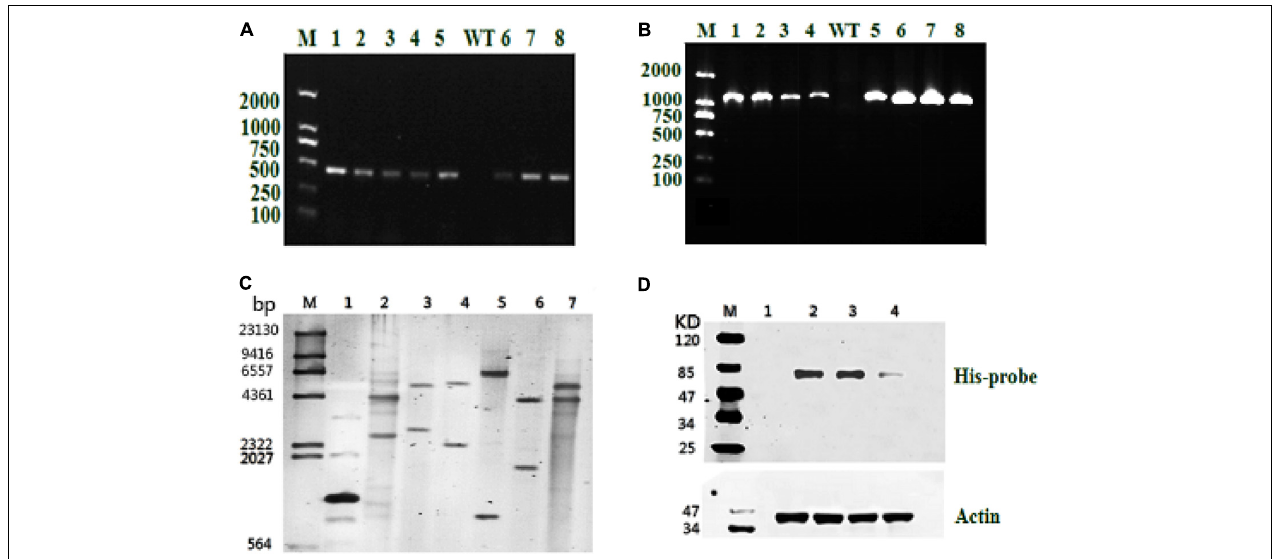
FIGURE 2 | Molecular analysis of resistant clones. (A) PCR of the resistant gene Sh-ble in selected clones and the WT strain. M: DNA-size marker. (B) PCR performed using primers designed from tandem ME1 and ble sequences in the recombinant plasmid pPha-T1-ME1. The reference band is 1126 bp. M: DNA-size marker. (C) Southern blot analysis of EcoR I-digested products (lane 1: positive control represents the plasmid, pPha-T1; lanes 2–4: PtME1-1, PtME1-2, and PtME1-3) and Kpn I-digested products (lanes 5–7: PtME1-1, PtME1-2, and PtME1-3) from genomic DNA with a ble fragment used as a digoxigenin-labeled probe. (D) Western blot analysis using an anti-His-tag antibody. Actin was used as an internal control (lanes 2–4: PtME1-1, PtME1-2, and PtME1-3).